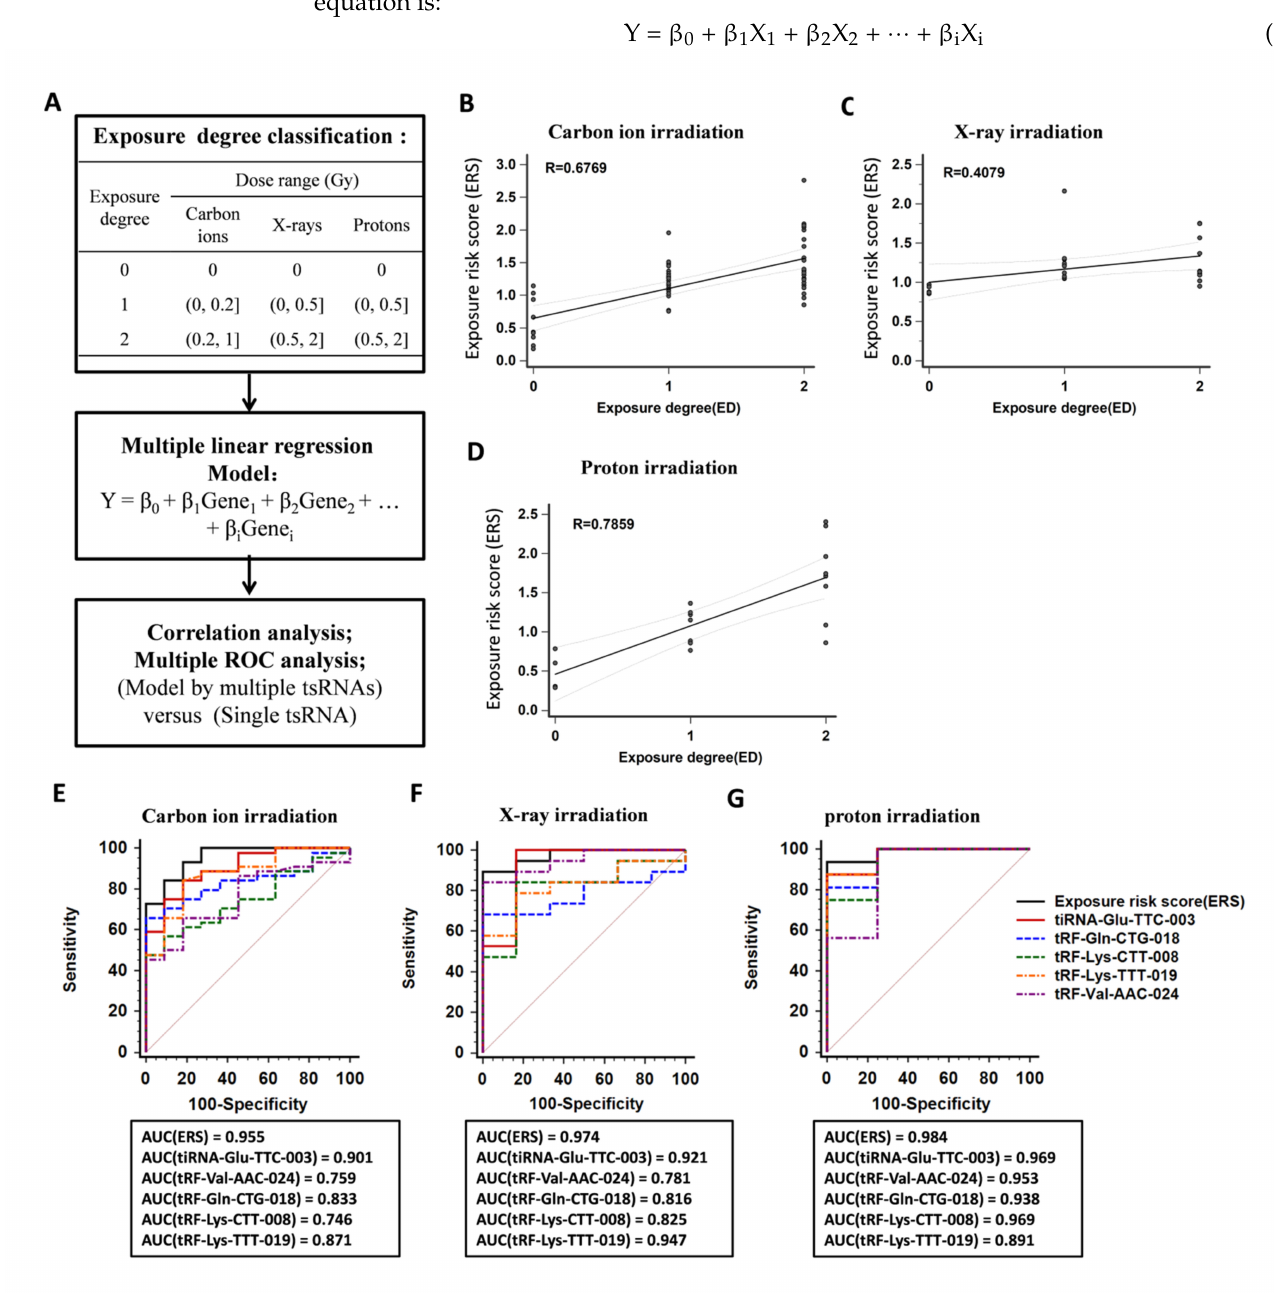
Figure 5. Establishment of a model based on multiple tsRNA biomarkers to indicate the degree of carbon ion, X-ray, or proton exposure. ( A ) A flow chart showing the establishment of the multi-factor models. ( B – D ) The relationship between exposure degree (ED) and exposure risk score (ERS) was predicted by the models from dose–response data of carbon ion, X-ray, and proton exposure. ( E – G ) Comparisons of ROC curves among the model and single tsRNA in triage of irradiated mice (AUC: area under ROC curve; Sensitivity: the percentage of individuals with irradiation who are correctly identified by the test; 100-Specificity: the percentage of individuals without irradiation who are correctly excluded by the